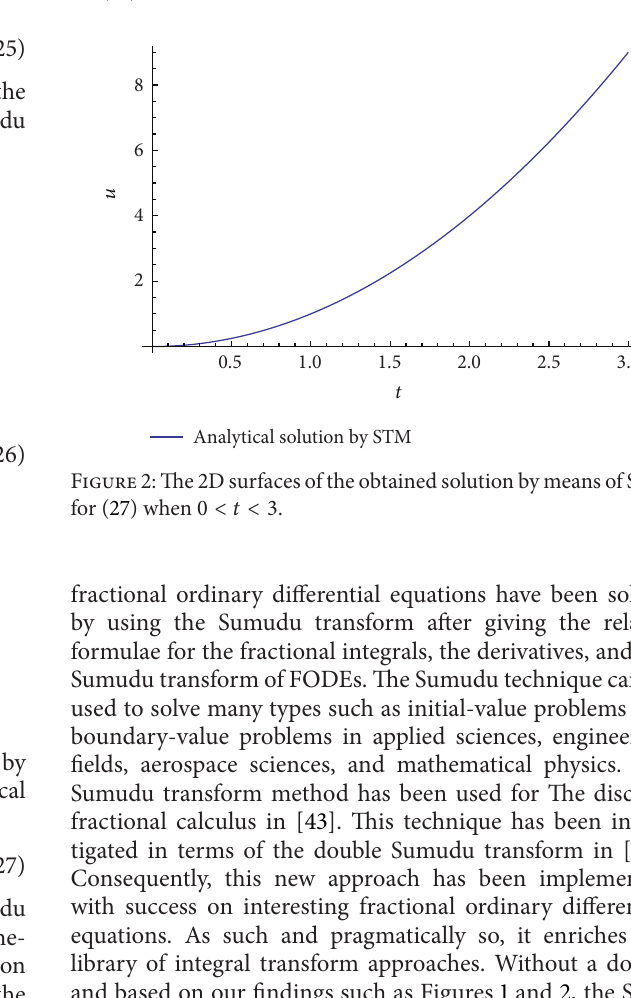
Figure 1: The 2D surfaces of the obtained solution by means of STM for (23) when 0 < 𝑡 < 3 .